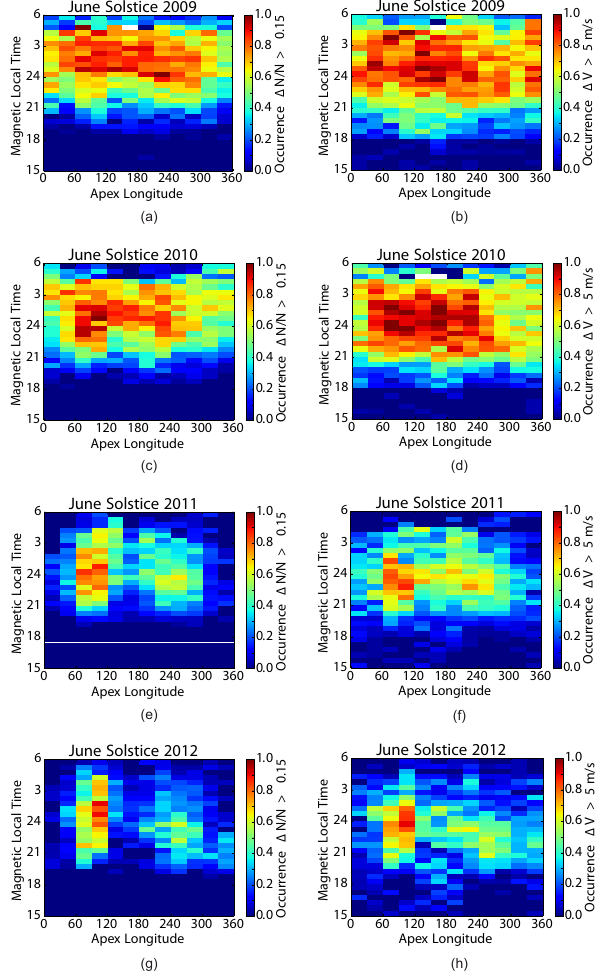
Fig. 4. Occurrence frequency of detecting irregularities with CINDI over the June solstice seasons. The format follows Fig. 3 though only 1N/N (a–g) and 1V (b–h) are shown.